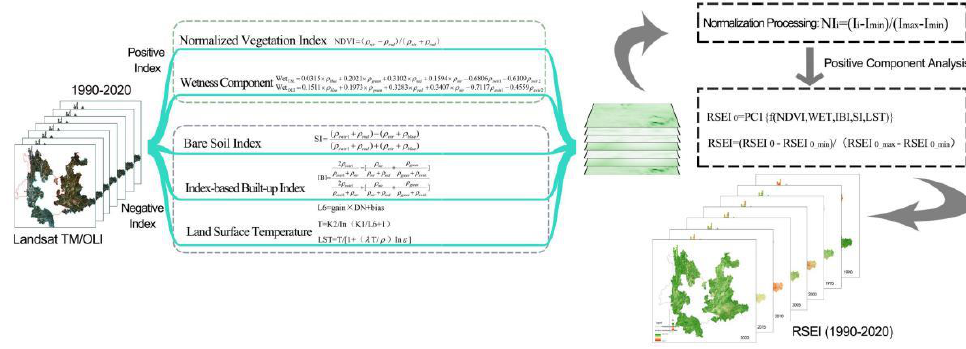
Figure 2. Steps for the extraction of ecological quality information (RSEI).